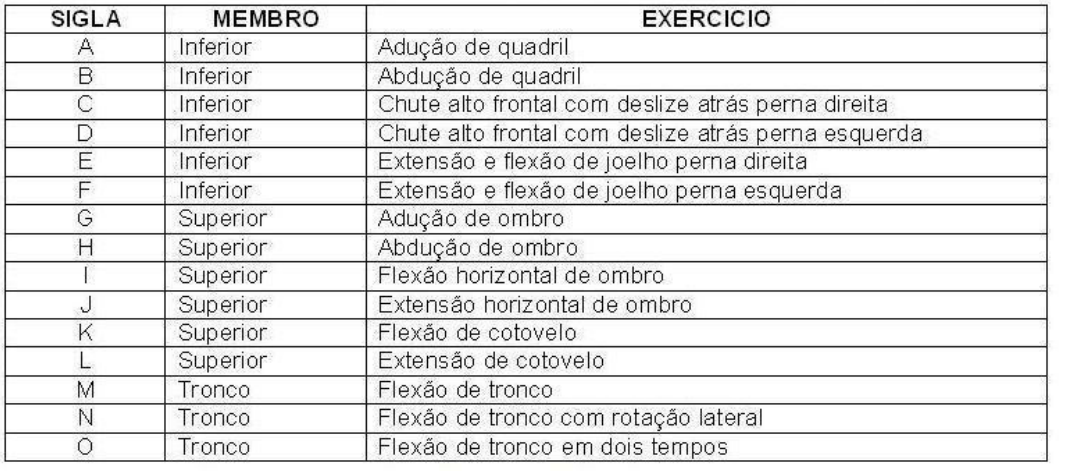
Figura 2. Exercícios do treinamento de força aquático. Quadro demonstrativo das siglas, membros atuantes e descrição dos